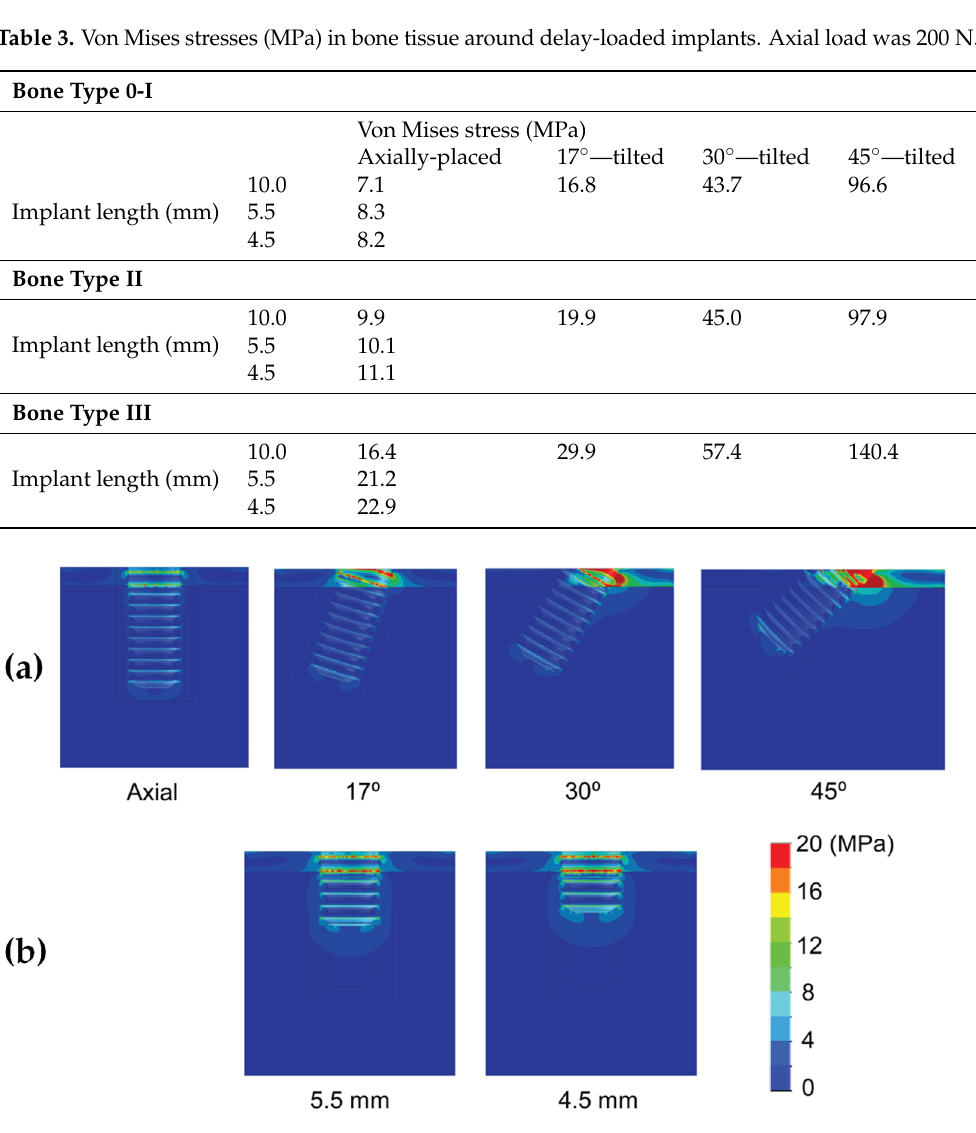
Figure 4. Von Mises stress distribution of immediately-loaded long 10 mm implant ( a ) and short implants (4.5 and 5.5 mm in length) ( b ) in bone type III.